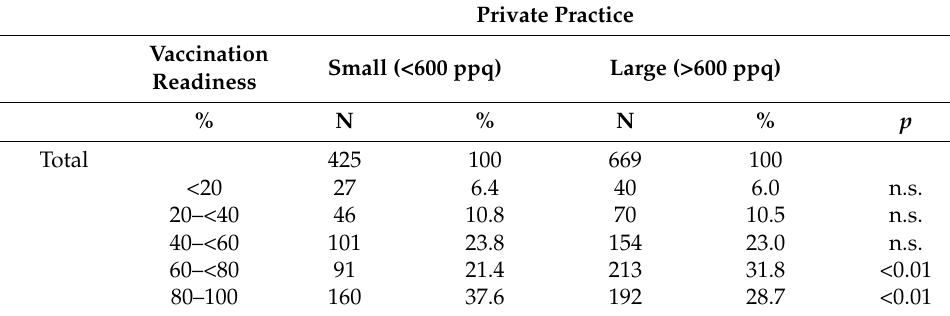
Table 9. Vaccination readiness by size of the private